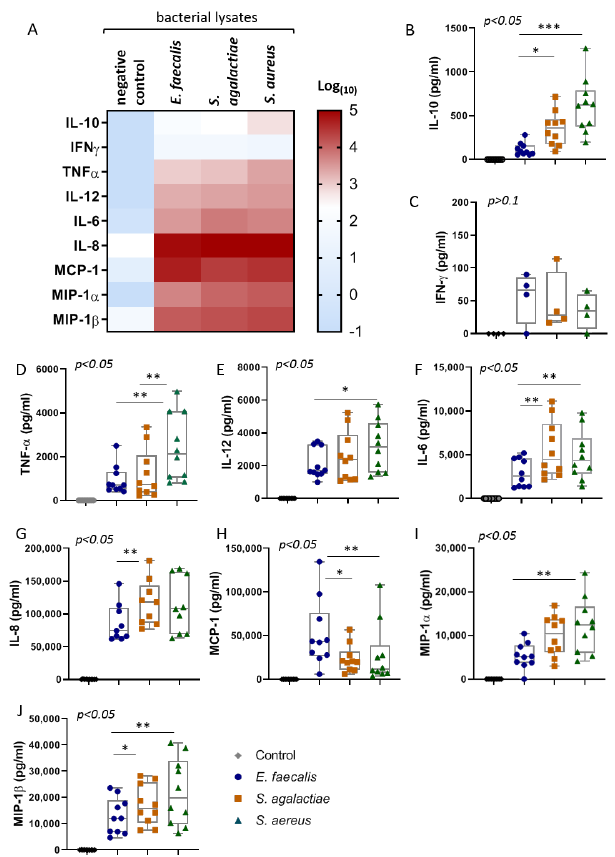
Figure 2. The bacterial lysates elicit distinct patterns of cytokines responses. ( A ) The heatmap depicts the median value for the cytokines and chemokines indicated in the left (rows), according to the bacterial stimuli (columns). The color scale is defined on the right. As the median values are reported in logarithmic (10) scale, values of 0 pg/mL were replaced by 0.1 pg/mL. ( B – J ) Boxplots for each one of the cytokines and chemokines analyzed upon stimulation with or without lysates from E. faecalis (circles), S. agalacticae (squares), S. aureus (triangles), and controls (diamonds). Overall statistical differences in the cytokine levels between the three bacteria lysate stimulations were compared using the nonparametric Friedman Test ( p values are presented in the top left of B–J). p values for the posterior multiple comparisons are depicted as * p < 0.05; ** p < 0.001; *** p < 0.0001 (Dunn’s Test correction). n = 10. IL-12 refers to IL12p40/70. Boxplots represent the median, minimum, and maximal values, whilst the dots depict the individual